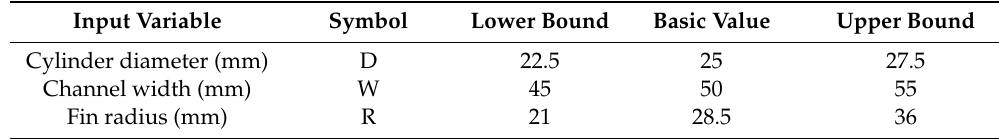
Table 3. The design space for each input variable.